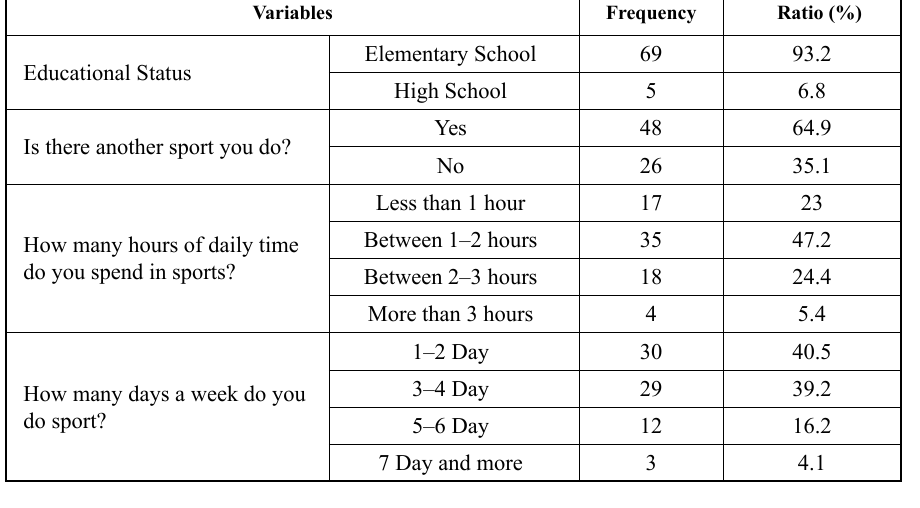
Figure 1. The views of re - search participants about